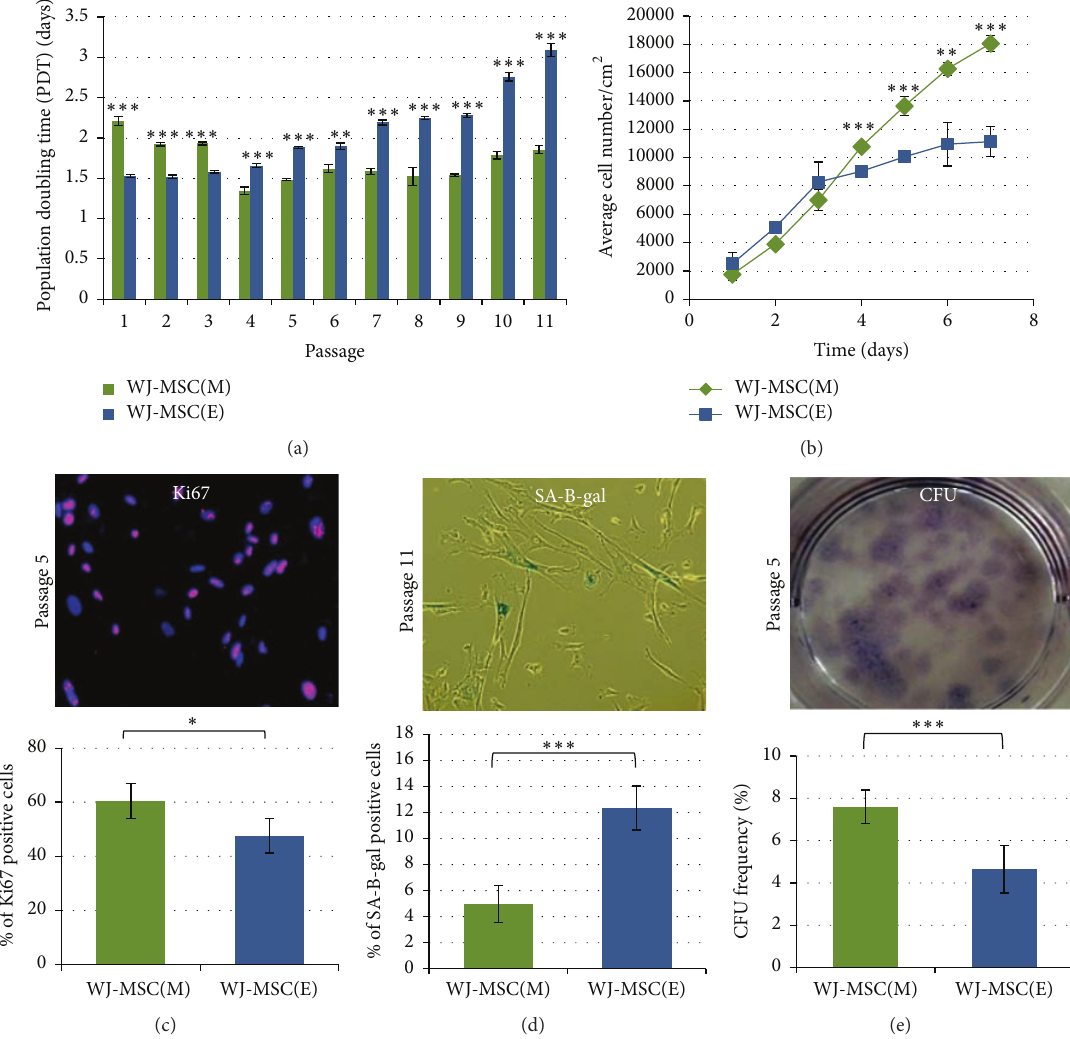
Figure 2: (a) Comparison of WJ-MSC(M) and WJ-MSC(E) population doubling time. Up to 11th passage PDT in WJ-MSC(M) remained at a relatively stable level of 1.5–2 days. In contrast, the WJ-MSC(E) have slowed down their cell divisions at the latest 3 passages (9–11). The results are mean values of 3 experiments ± SD. ∗∗ 𝑝 < 0.01 ; ∗∗∗ 𝑝 < 0.001 . (b) Cell growth analysis. Only WJ-MSC(M) presents a linear growth rate. After 7 days of culture the average number of WJ-MSC(E) was significantly lower than that of WJ-MSC(M). The results are mean values of 3 experiments ± SD; ∗∗ 𝑝 < 0.01 ; ∗∗∗ 𝑝 < 0.001 . (c) Cell proliferation. Decrease of WJ-MSC(E) proliferation rate correlated with decreased number of Ki67 reactivity. The results are mean values of 3 experiments ± SD. ∗ 𝑝 < 0.05 (d) Percentage of senescent cells counted at 11th passage. The number of cells expressing 𝛽 -galactosidase is significantly higher in WJ-MSC(E) than WJ-MSC(M). The results are presented as mean values of 3 experiments ± SD, ∗∗∗ 𝑝 < 0.001 . (e) Quantification of CFU frequency. WJ-MSC isolated by mechanical method have significantly greater ability to create colonies. The results are presented as mean values of 3 experiments ± SD; ∗ 𝑝 < 0.05 ; ∗∗ 𝑝 < 0.01 ; ∗∗∗ 𝑝 < 0.001